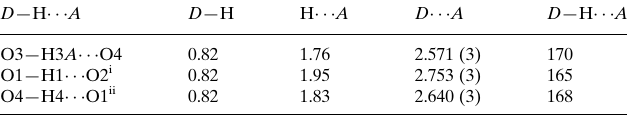
Hydrogen-bond geometry (A˚ , (cid:3)